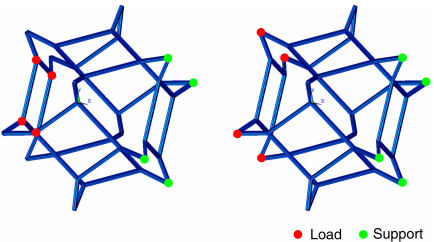
Figure 4. Boundary conditions in first loading mode (left) and in the second loading mode (right).